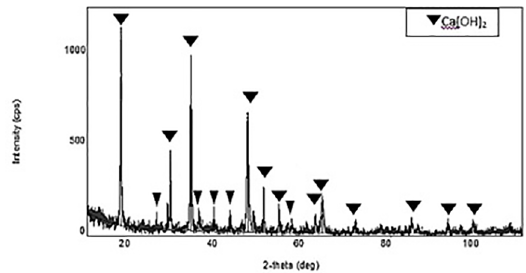
Figure 1. The XRD diffraction pattern of calcium hydroxide Figure 2 shows the scanning electron microscopy (SEM) of synthesized calcium hydroxide. As it shows the calcium hydroxide particles have hexagonal plate like morphology with very fine thicknesses, which results in the highest specific surface area and highest reactivity.